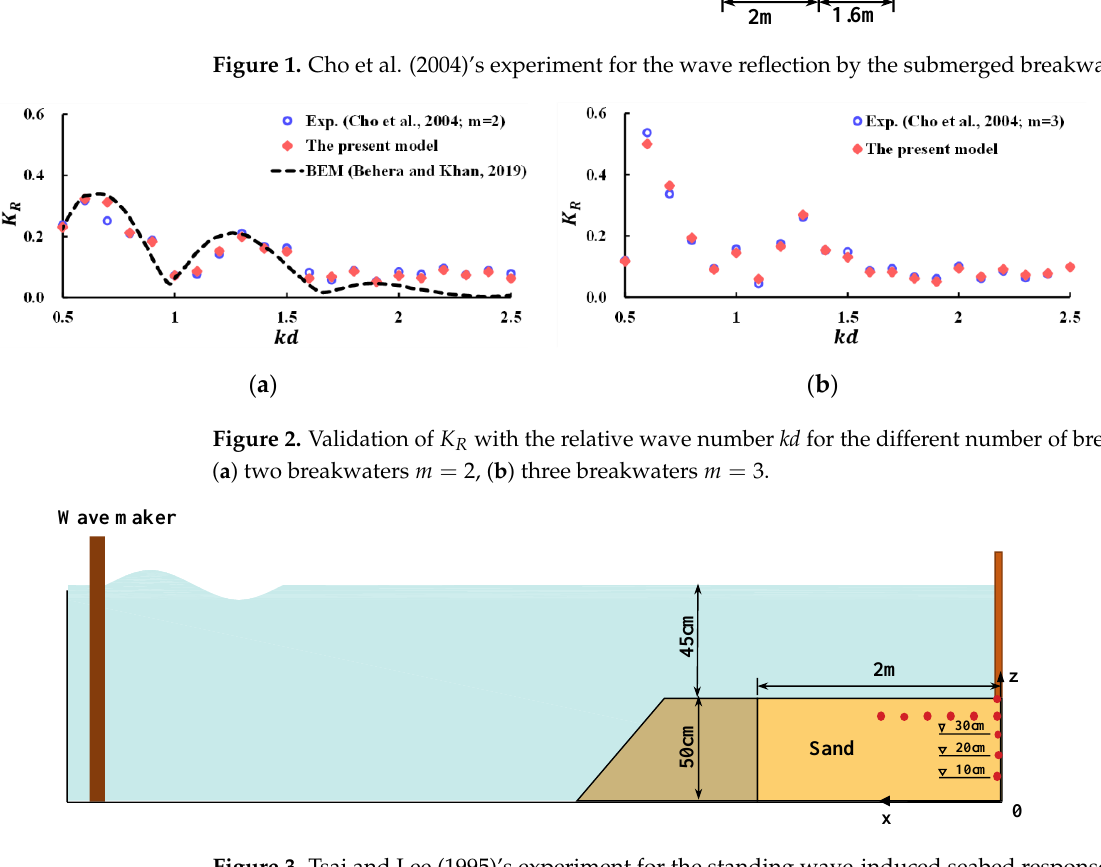
Figure 2. Validation of 𝐾 𝑅 with the relative wave number kd for the different number of breakwa- ters: ( a ) two breakwaters 𝑚 = 2 , ( b ) three breakwaters 𝑚 = 3 .